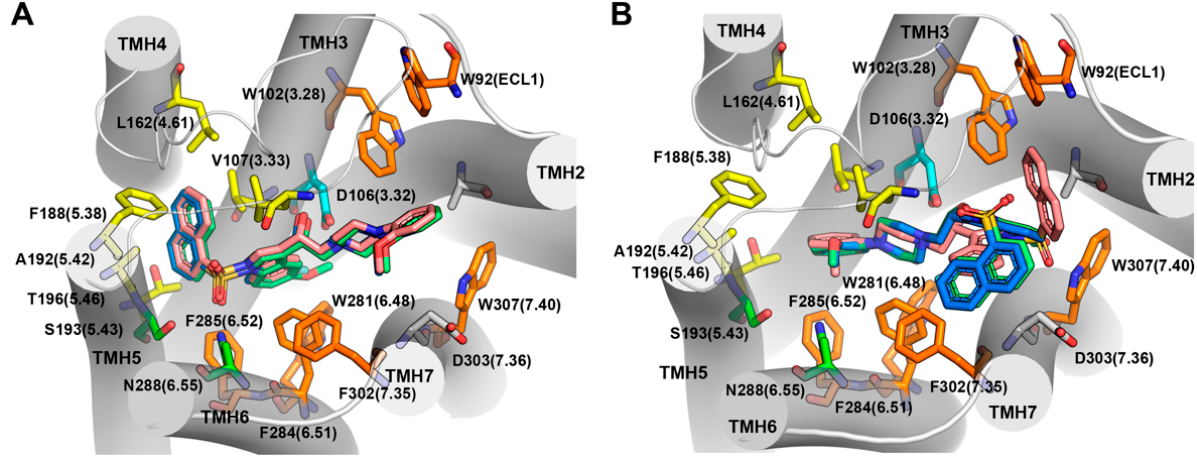
Figure 2. FRED-obtained binding modes for compounds PUC-10 (sky-blue), 4d (deep salmon) and 4l (lemon) in ( A ) S conformation and ( B ) R conformation. Residues in orange depict the hydrophobic cluster in TMH-6 and TMH7 regions; yellow depicts residues in TMH-3 and TMH-5 surrounding the binding pocket, cyan depicts Asp106 (3.32) implicated in Scheme 288. (6.55) and Ser193 (5.43) implicated in hydrogen bond interactions (residues are also indicated under Ballesteros–Weinstein nomenclature [28]).